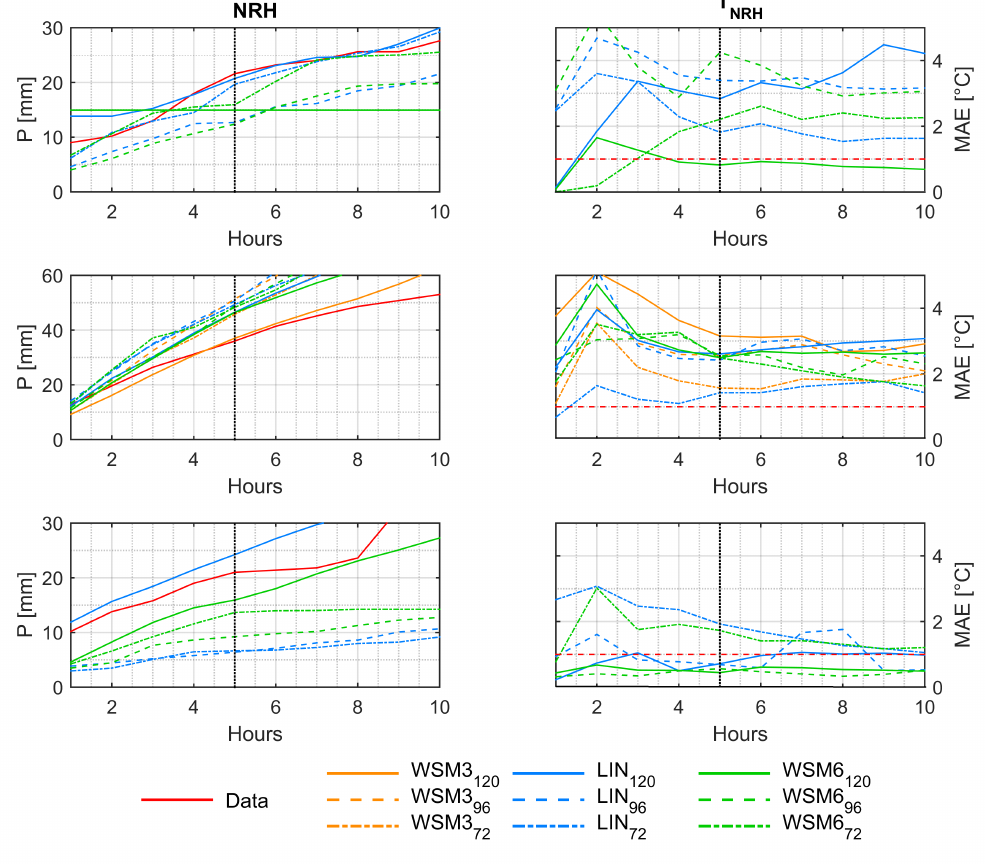
Figure 6. Observed and simulated N rainiest hours (NRH, left ) and T NRH MAE ( right ) from 1 to 10 h, for OCT15 ( upper row), APR16 ( central row) and MAY17 ( lower row) simulations. The vertical black dotted line represents the Quebrada de Ramón time of concentration. Three lead times (72, 96 and 120 h) and three MP parameterizations (LIN, WSM6 and WSM3 when used) are